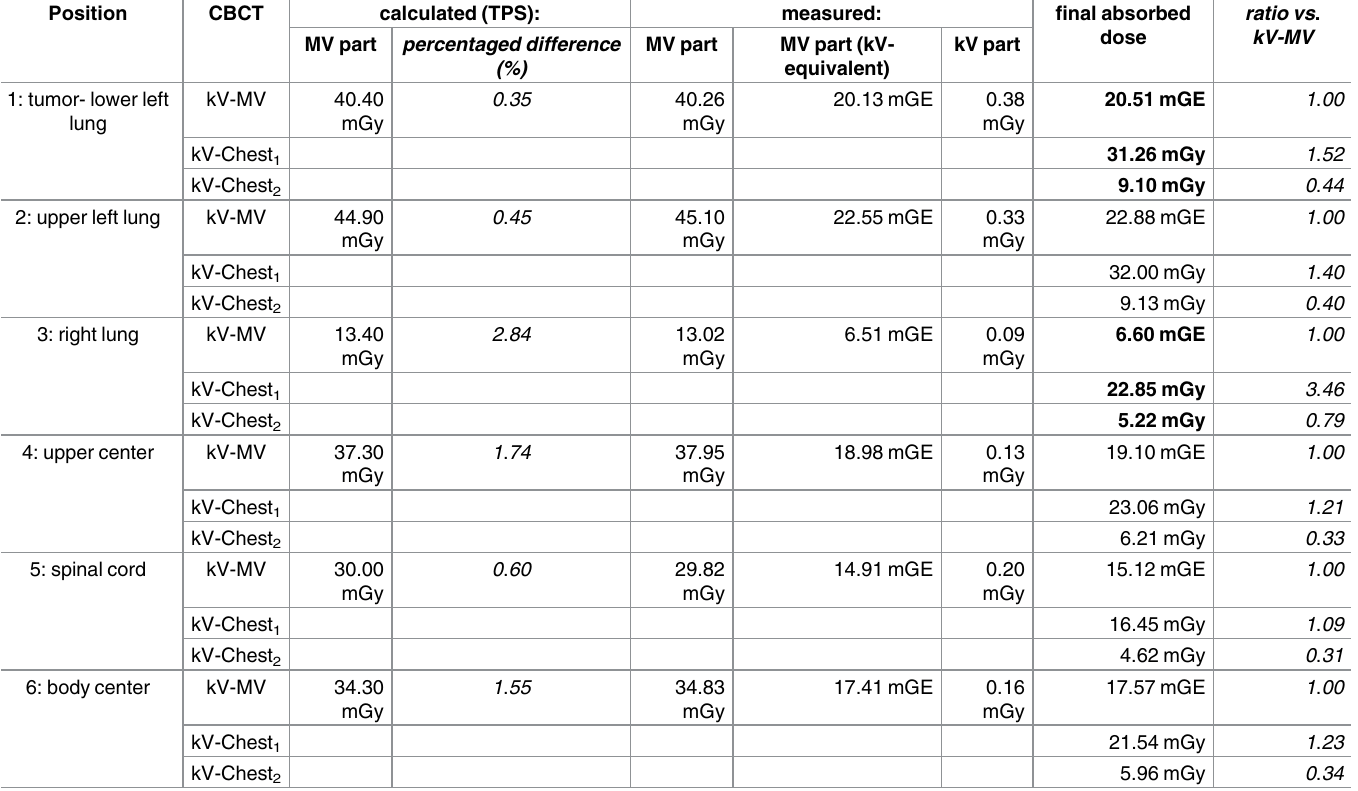
Table 3. Absorbed dose for different presets in inhomogeneous thorax phantom (column 8), ratio between the imaging methods and reference dose output kV-MV (D/D ref ) (column 9), comparison of MV-contribution dose output between measuredand calculated (TPS) absolute dose by per- centage difference (column 3–5), and separatecontributions of kV- and RBE-corrected MV absorbed dose to kV-MV-CBCT in columns 6+7 (GE: Gray-equivalent with RBE = 2 for kV-dose contribution).